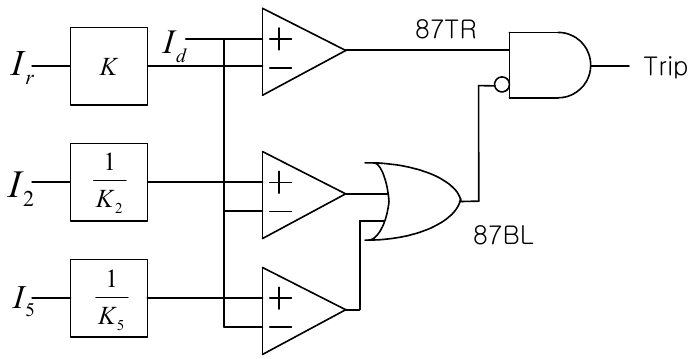
Figure 5. Conventional differential relay with harmonic